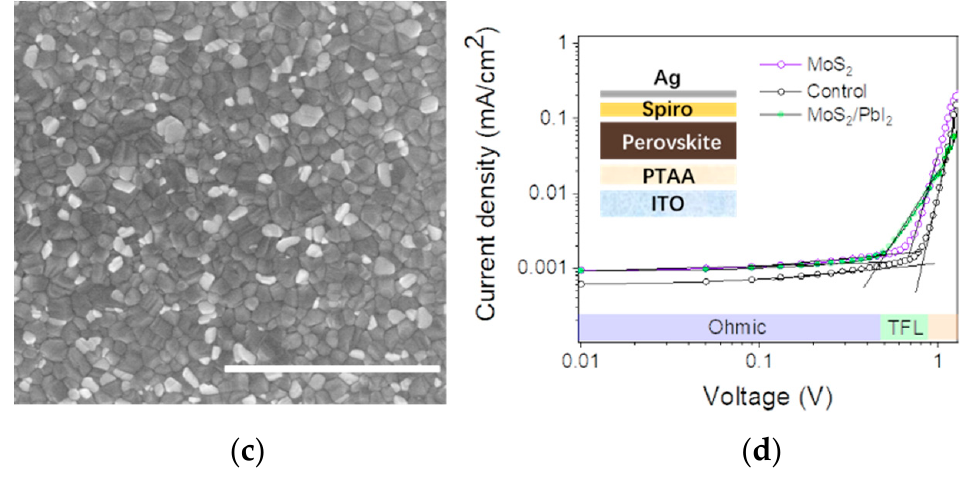
Figure 8. ( a , b ) The films after mechanical exfoliation treatment without PbI 2 morphology. ( c ) The film with MoS 2 and PbI 2 . Scale bar in the SEM images is 3 µ m. ( d ) SCLC measurement device treated with MoS 2 , with and without PbI 2 . Inset: the hole-only devices structure diagram.